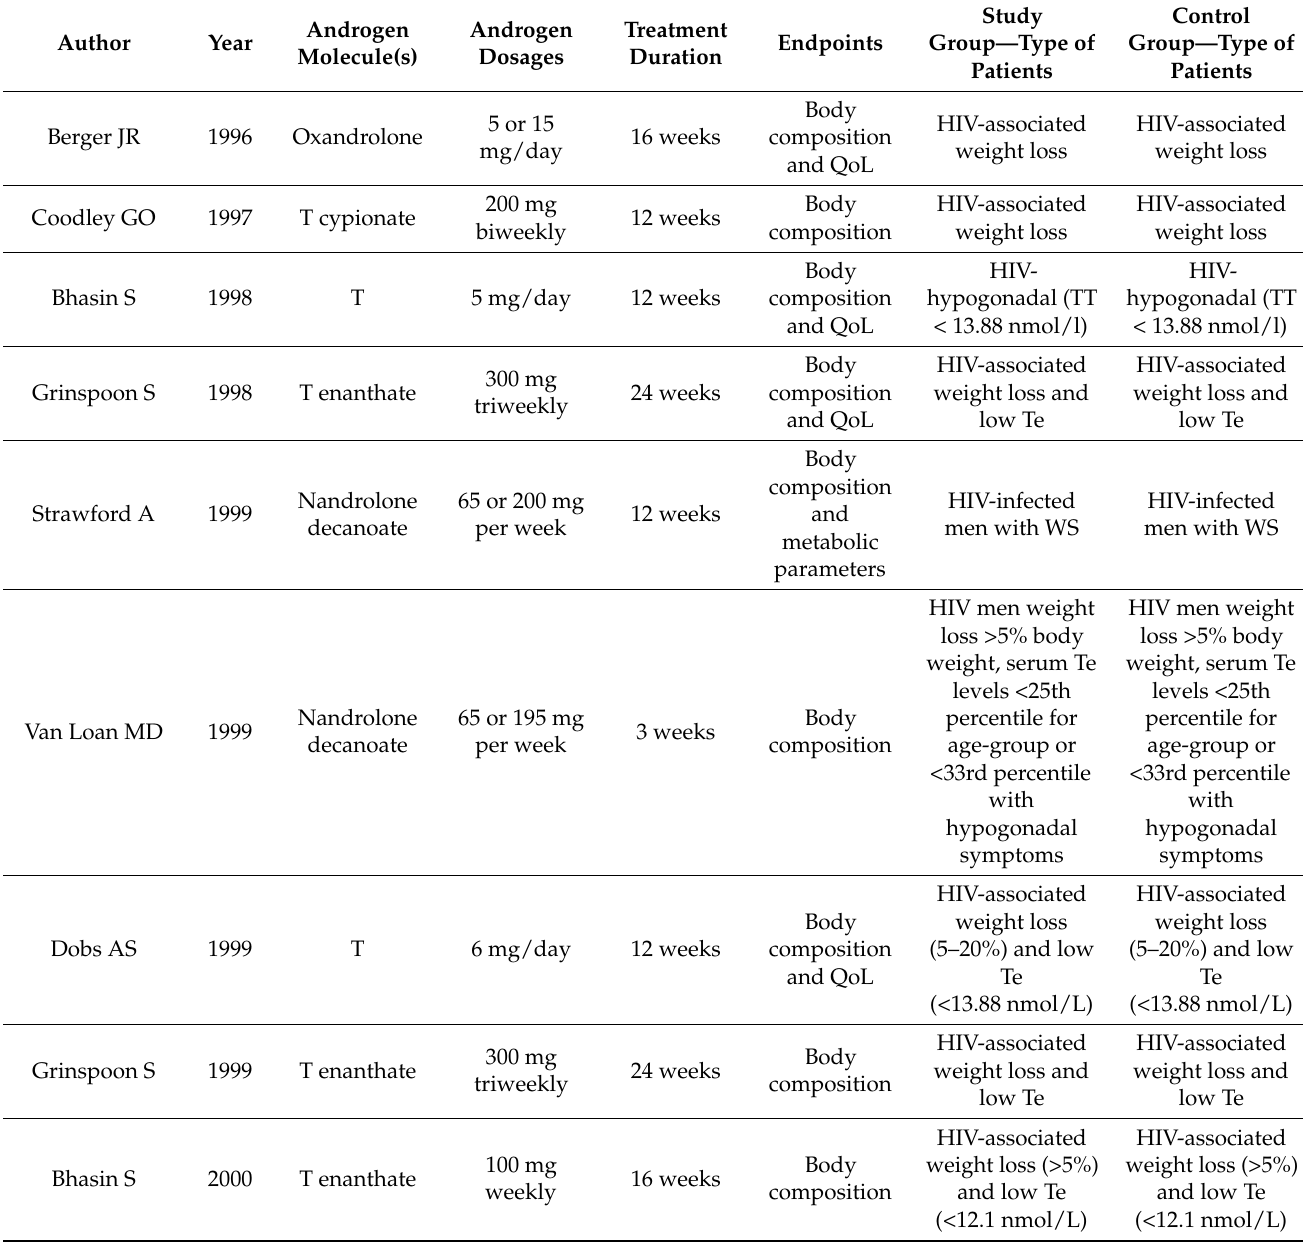
Table 2. Characteristics of studies included in the meta-analysis (search